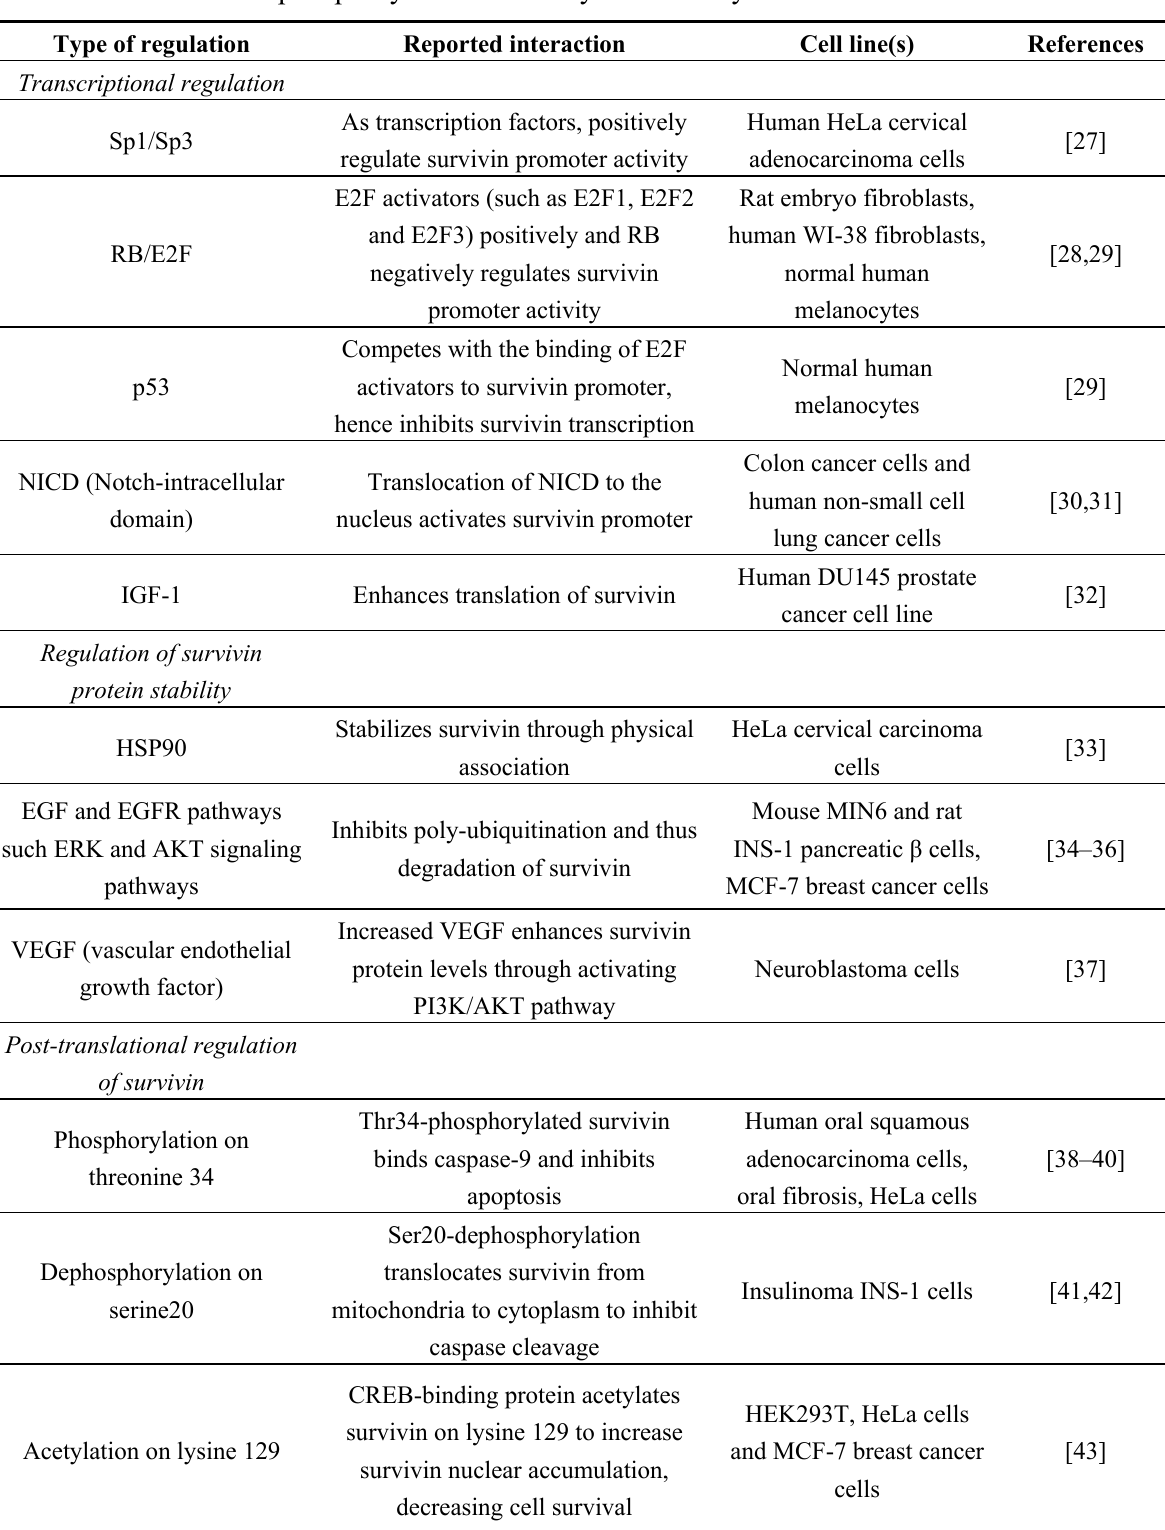
Table 1. Summary of the main pathways through which survivin is regulated. Survivin levels and localization can be regulated by changes in transcription, physical association with chaperones, altering proteosomal degradation, and by other post-translational mechanisms such as phosphorylation and acetylation of key amino acid